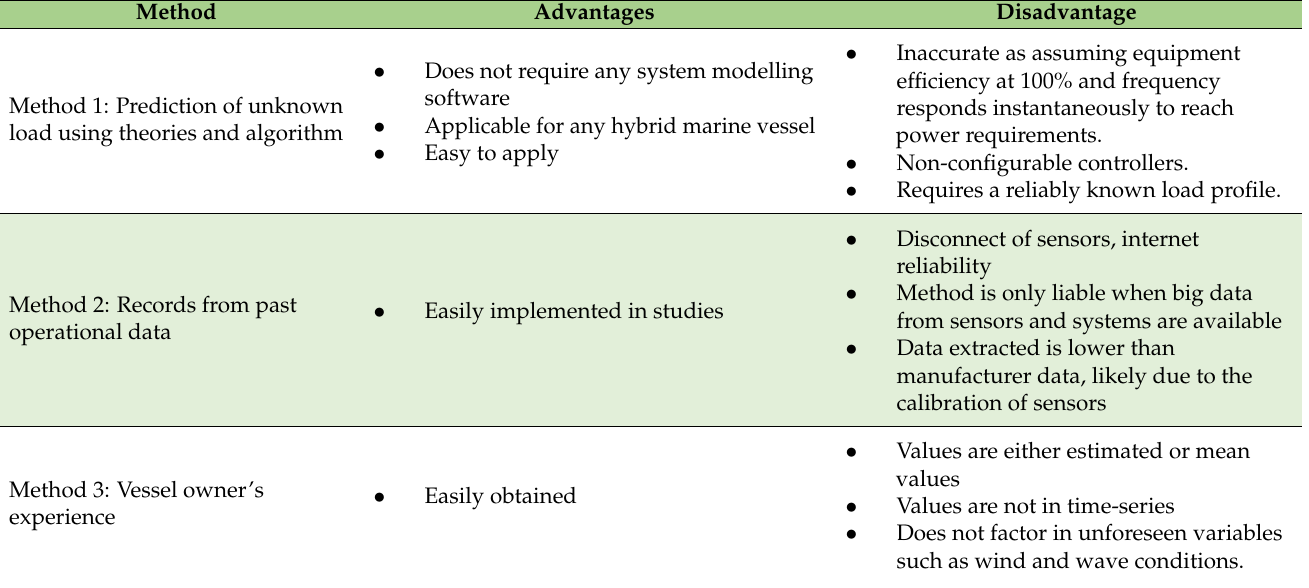
Table 2. Advantages and disadvantages of respective loading profile